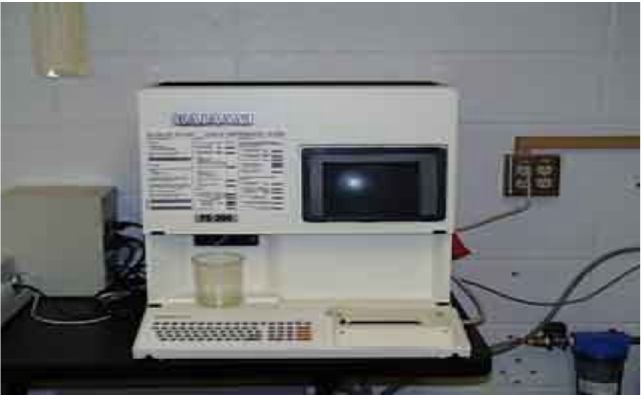
Figure 16. A Kajaani FS-200 Fibre Analyser.